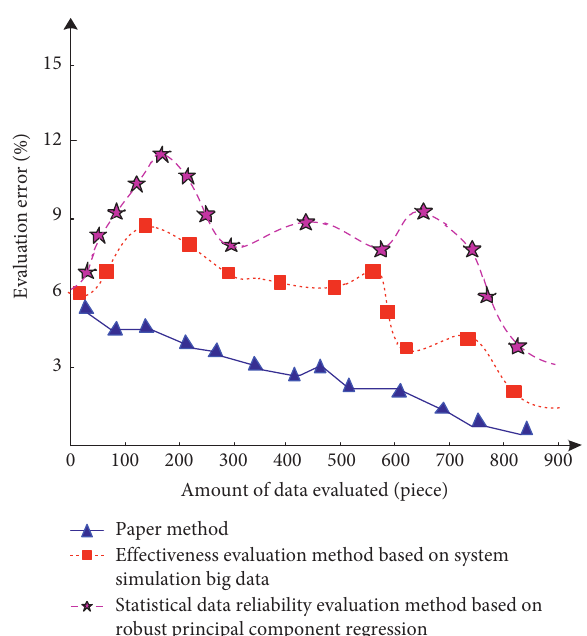
Figure 5: Analysis of evaluation error results of different